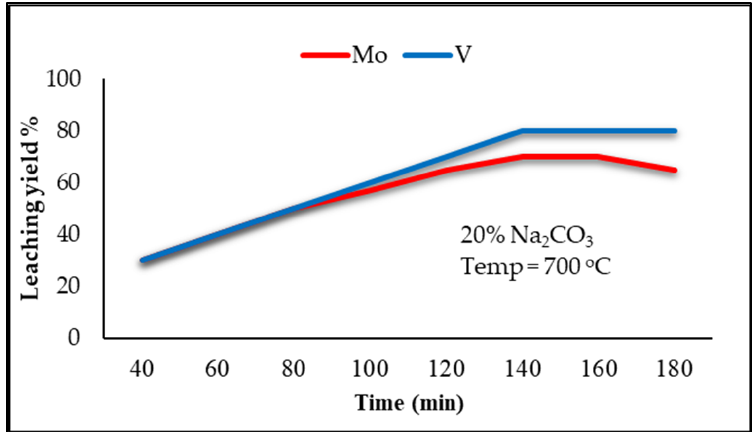
Figure 3. Leaching of molybdenum and vanadium vs. time (T: 700 °C).